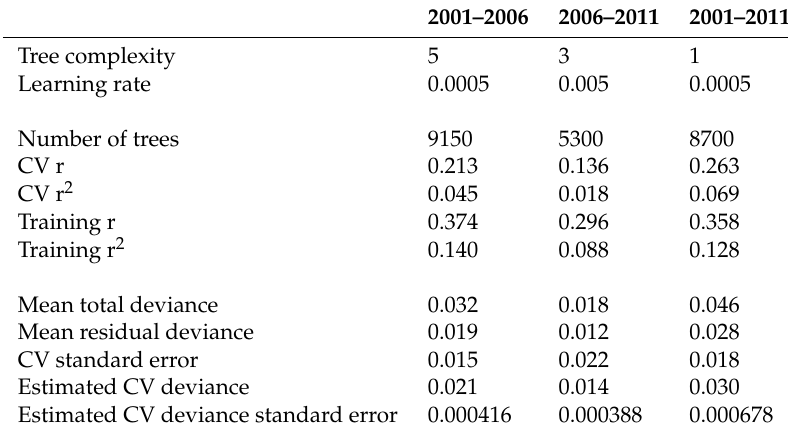
Table 2. Boosted regression tree (BRT) model